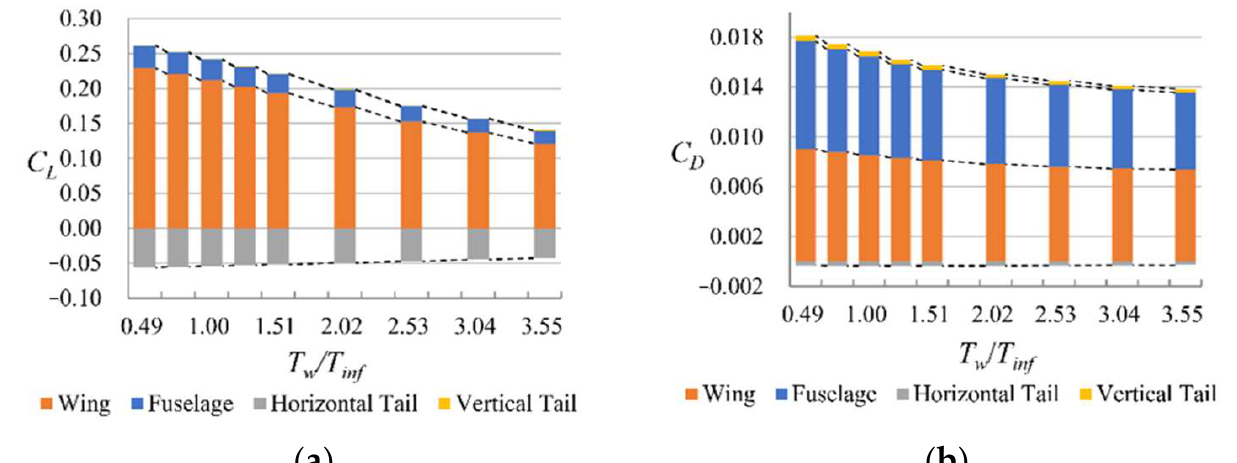
Figure 7. Effect of wall-temperature gradient on C L and C D of each component. ( a ) C L – T w / T inf ; ( b ) C D – T w / T inf .